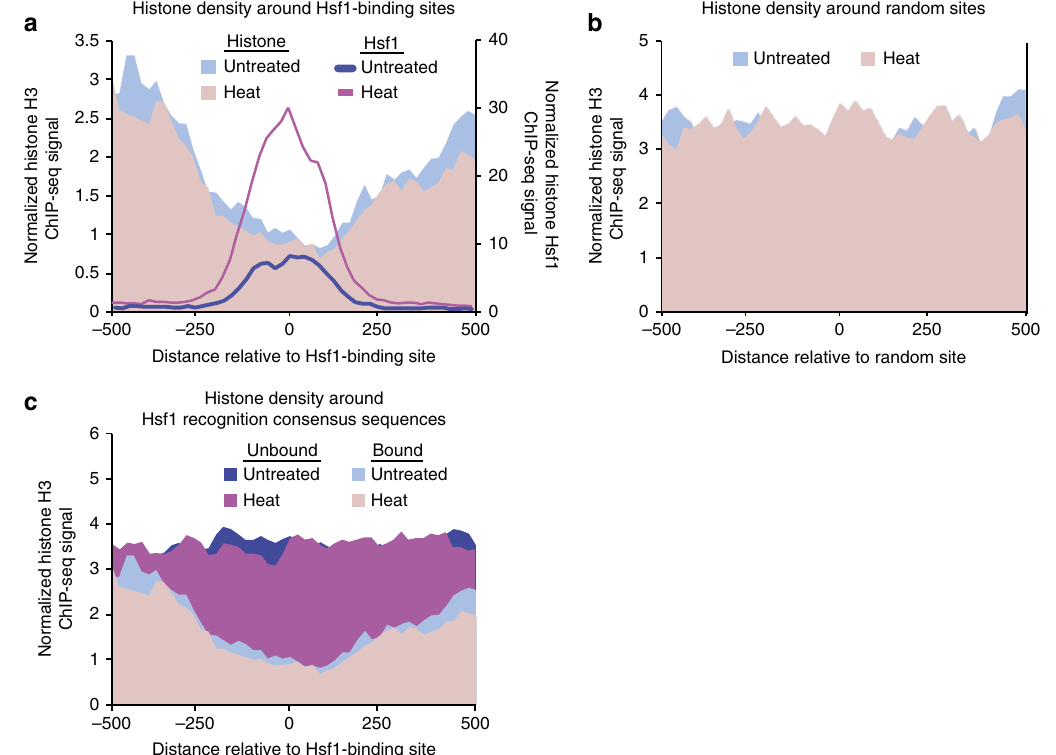
Figure 3 | Nucleosome positioning affects Hsf1 DNA binding. ( a , b ) Schematic plots illustrating nucleosome density (shaded area) and Hsf1 binding (lines) at ( a ) Hsf1-binding sites and ( b ) random genomic regions before (blue) and after (red) heat shock. ( c ) Nucleosome density around genomic regions containing Hsf1 recognition consensus sequences with (bound) or without (not bound) Hsf1 (as determined by Hsf1-TAP ChIP-seq analysis) before (blue) and after (red) heat shock. Nucleosome and Hsf1-TAP levels were measured by Histone H3 and Hsf1-TAP ChIP-seq, respectively. NATURE COMMUNICATIONS|7:11704|DOI: